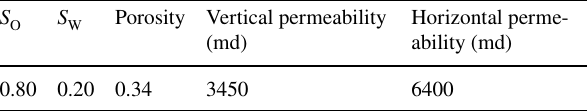
Table 3 Field-scale thermal cracking reaction schemes and their kinetics parameters (Rabiu Ado 2017)